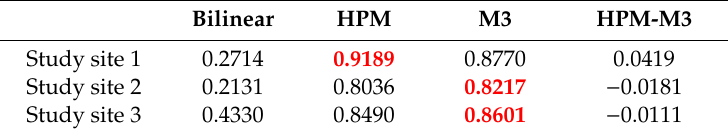
Table 9. Spatial subset Q 2 n values derived considering the six Sentinel-2 20 m sharpened bands (Table 1) together ( n = 6). The highest Q 2 n value (least distortion) for each study site is shown in red bold font, and if values are within two decimal places (i.e., | HPM-M3 | < 0.01), then both are shown in red